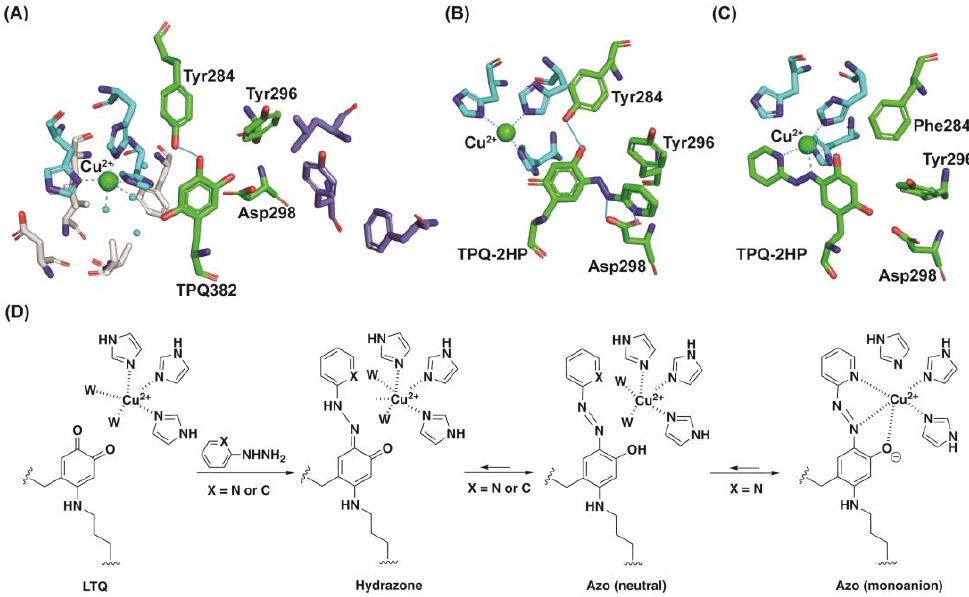
Figure 10. The active site environment of AGAO and LOXL2. ( A ) TPQ resides in between the Cu 2+ − and O 2 − binding sites (in light blue and in grey) and the substrate − binding site/entry channel (in dark blue). A hydrogen − bonding interaction between O4 (oxoanion) of TPQ and Tyr284 (in blue line) limits the mobility of TPQ [11]. ( B ) TPQ − 2HP detected in WT − ECAO [26]. The residue numbering was edited to match with those of AGAO. ( C ) TPQ − 2HP ligated on Cu 2+ detected in Y284F − ECAO where Cu 2+ − ligation generates dianion of TPQ − 2HP [29]. The residue numbering was edited to match with those of AGAO. ( D ) Formation of LTQ − 2HP (azo) mono − anion by ligating to the active site Cu 2+ .The 2HP (X=N) adduct ligates to the active site Cu 2+ but the PH (X=C) adduct does not. W: water molecule.